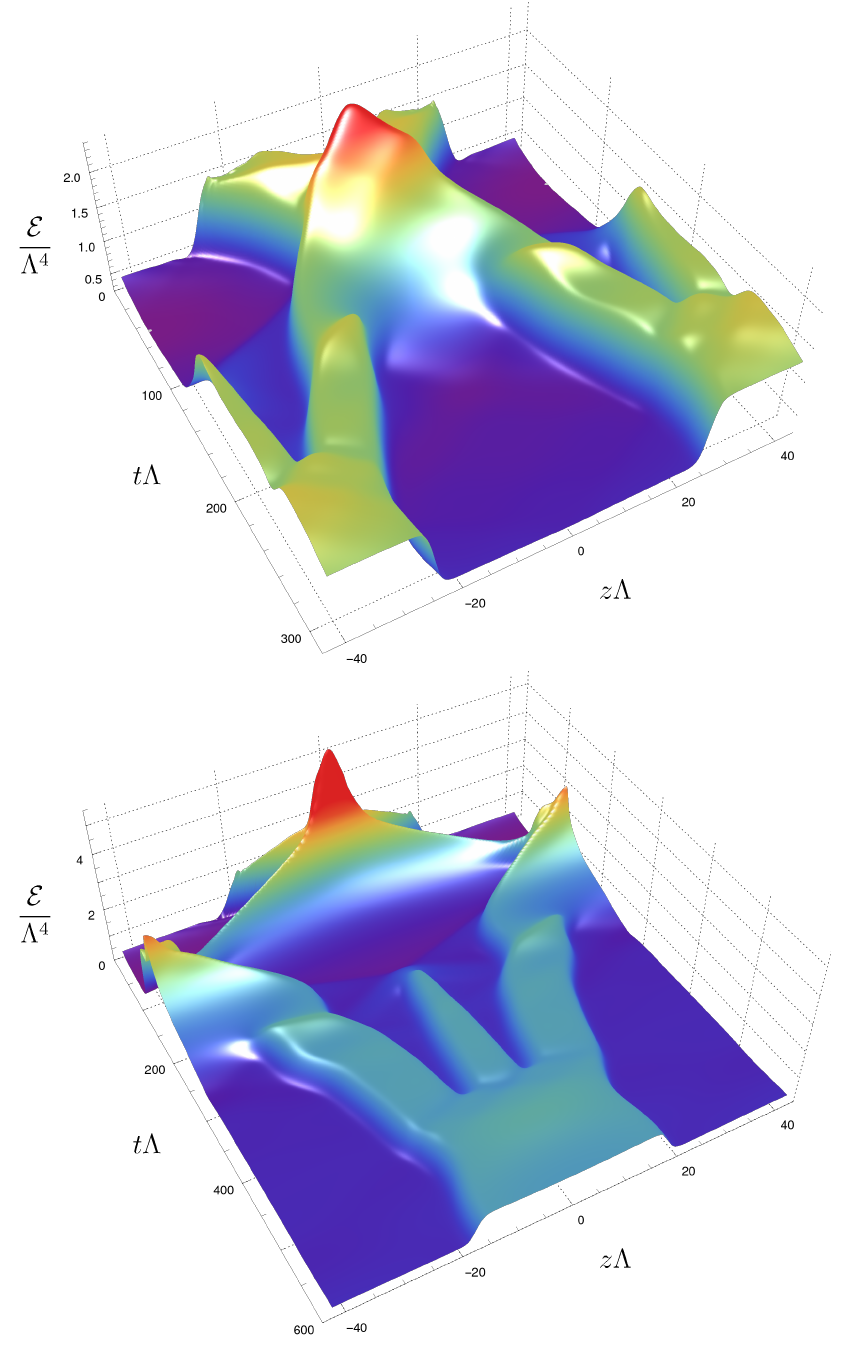
Figure 19 . Evolution of the energy density for simulations with v max = 0 . 25 (top) and v max = 0 . 73